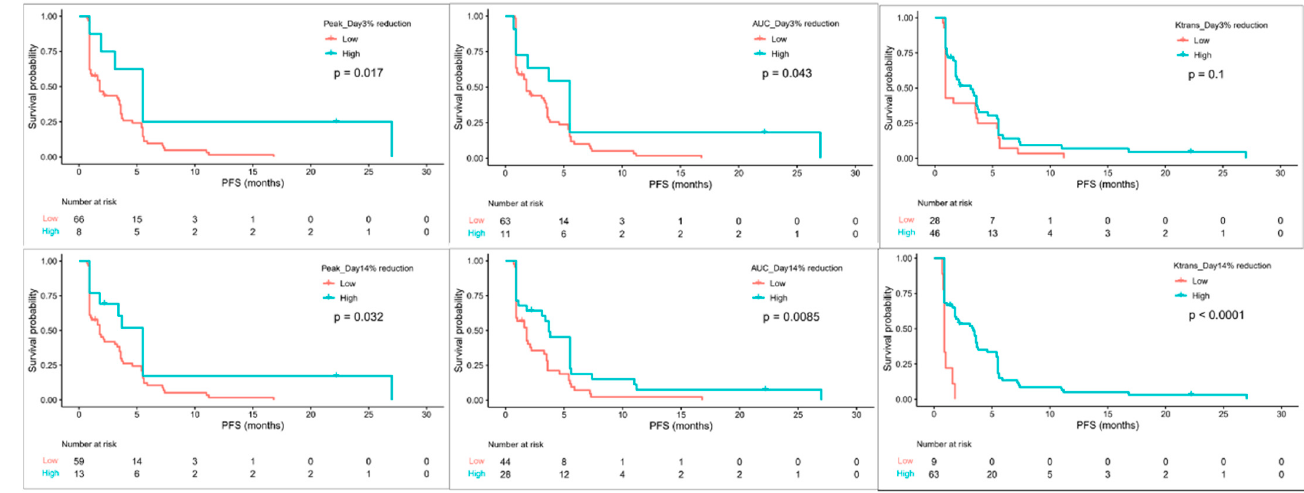
Cancers 2021 , 13 , x FOR PEER REVIEW Figure 3. Kaplan – Meier survival curves of PFS grouped by changes in DCE-MRI biomarkers on day 3 and day 14.